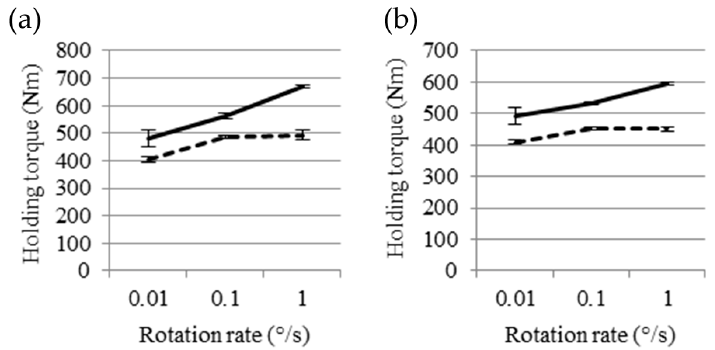
Figure 10. Engagement torque versus quasi-static holding torque for various friction materials.